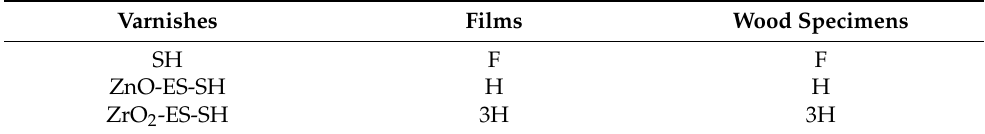
Table 3. The results of the pencil hardness